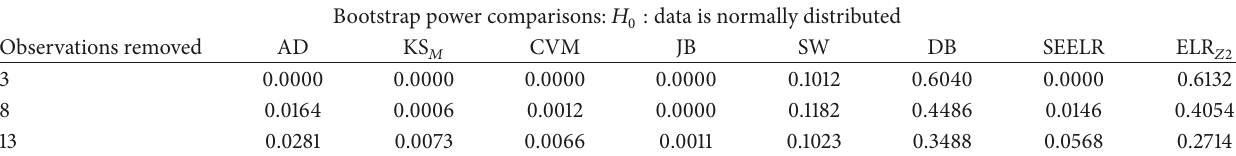
Table 3: Bootstrapping using the inverse exponential transformed baby boom data.